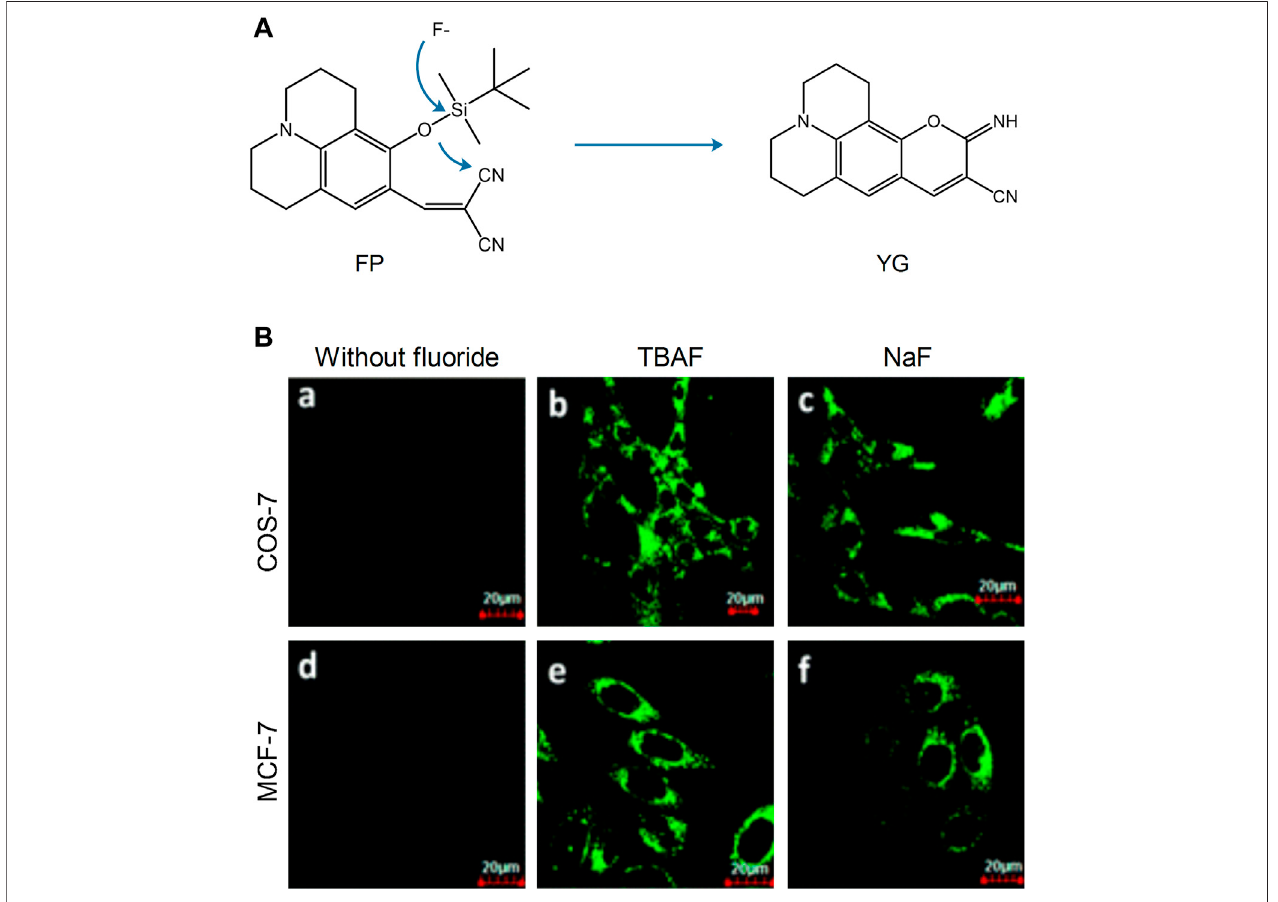
FIGURE 5 | The reaction mechanism and fl uorescence imaging of probe FP (Shiling et al., 2014). (A) Proposed reaction mechanism of FP . (B) Fluorescence imaging of COS-7 and MCF-7 cells incubated with probe FP (2.5 μ M) before (a and d) and after (b, c, e, and f) being treated with TBAF, NaF (100 μ M).